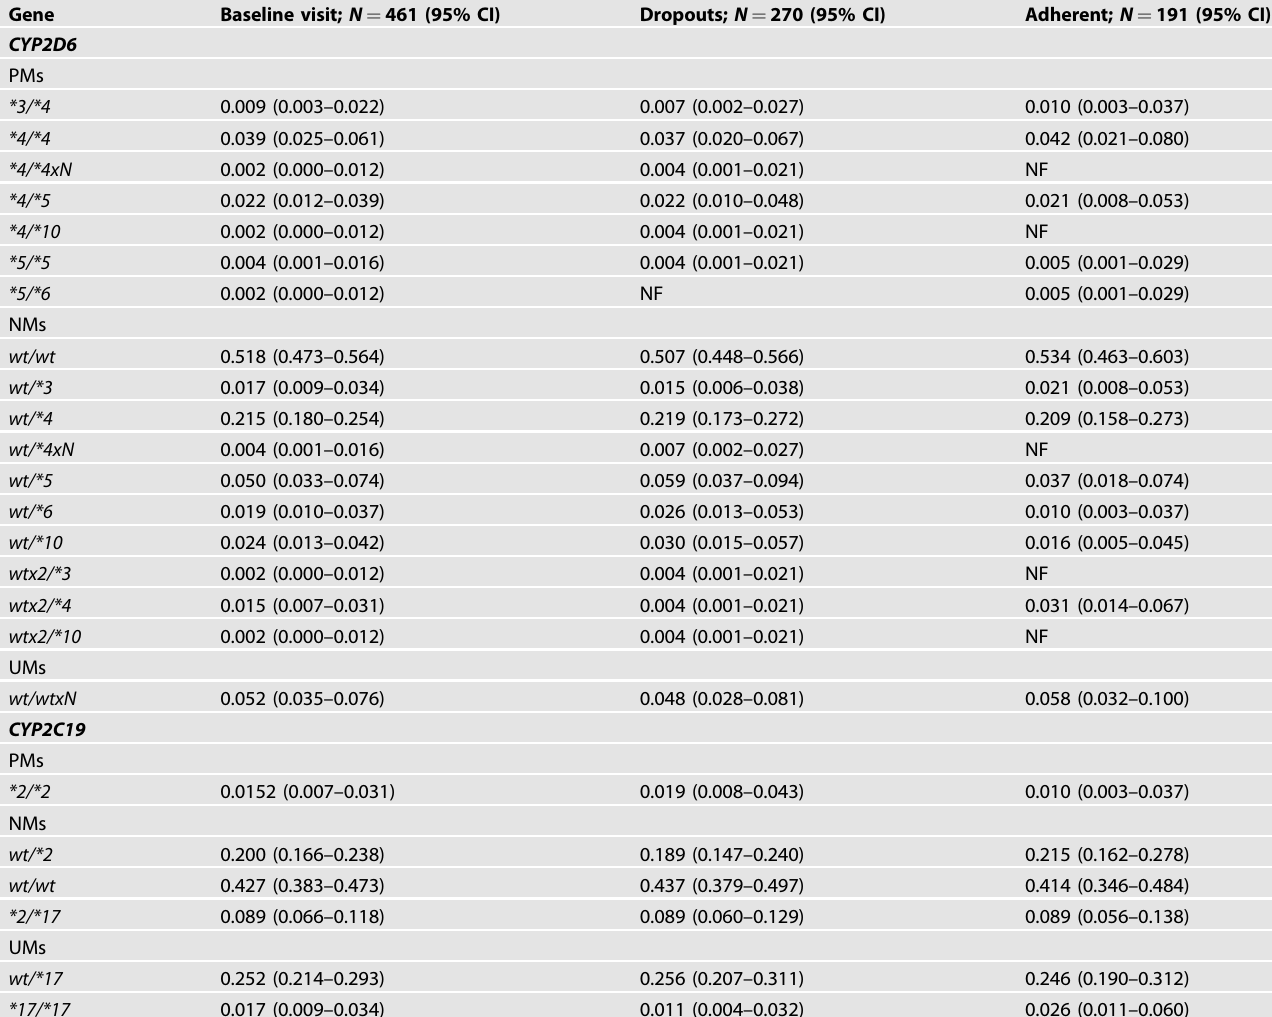
Table 1. Frequency of CYP2D6 and CYP2C19